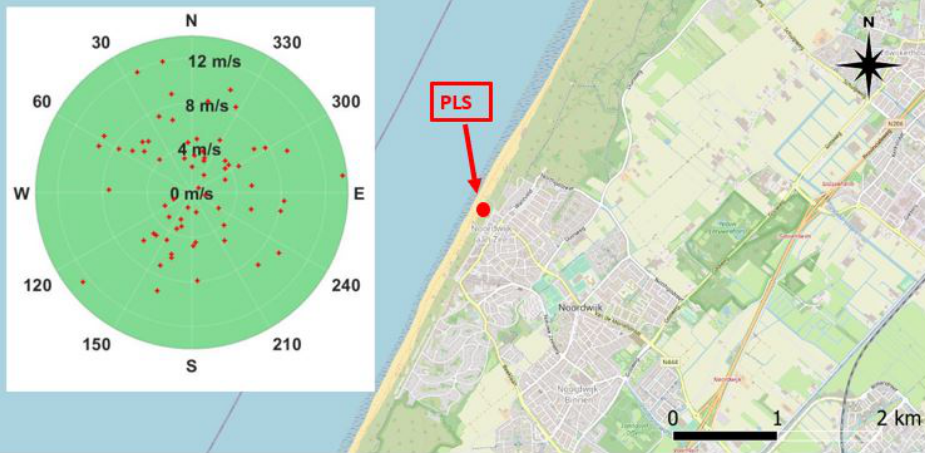
Figure 3. Scatter plot of the local wind direction (0° = North; 90° = East) and wind speed (m/s; represented on the radius) collected during the days of the stack at the moment of the satellite passing. The PLS location is highlighted in red. Background image: